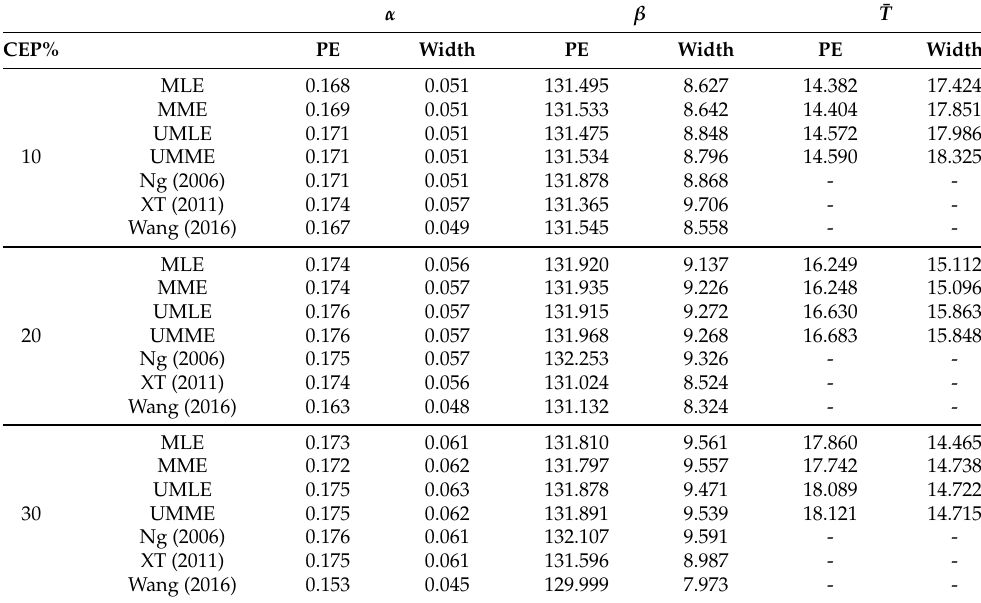
Table 4. Point estimates (ˆ α , ˆ β , and ¯ T ) and widths of the corresponding confidence intervals for different censoring